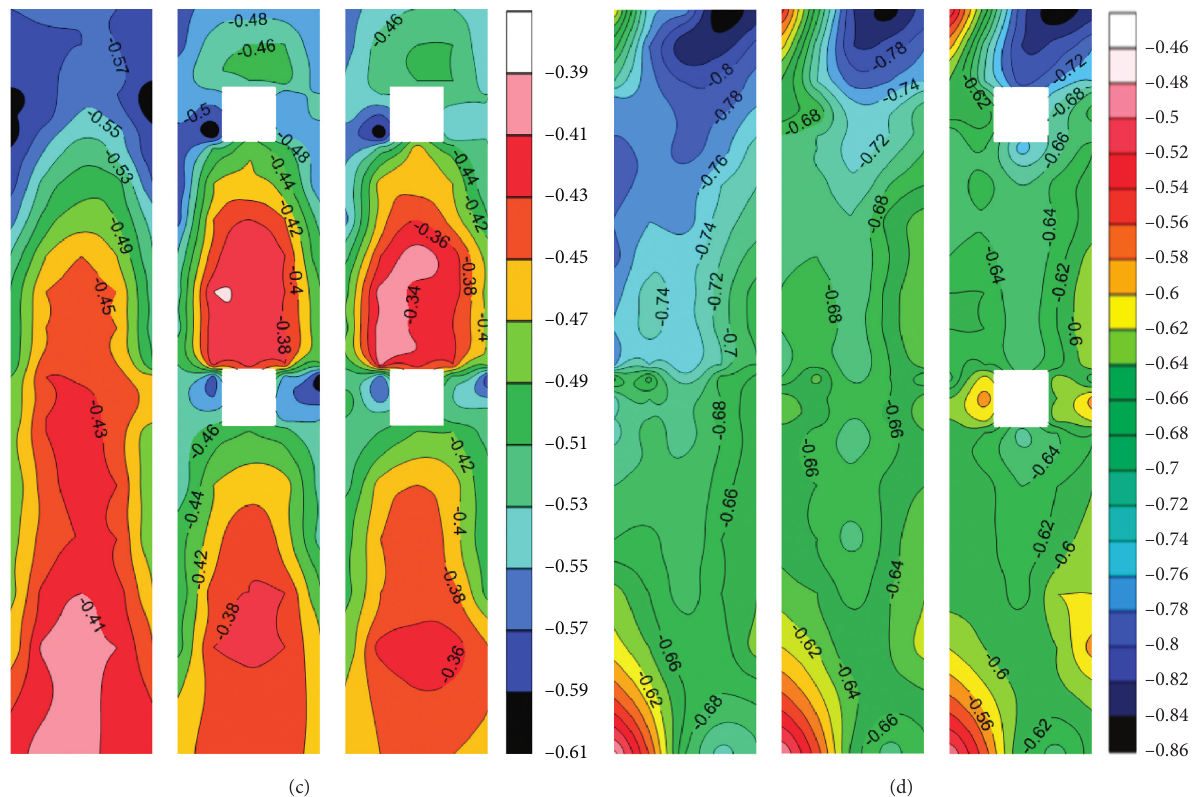
Figure 14: Distribution of mean wind pressure coefficients on the façades under the wind direction of 0 ° . (a) Windward surface (from left to right, L-1, L-2, and L-3, the same below). (b) Right-side wind surface. (c) Leeward surface. (d) Left-side wind